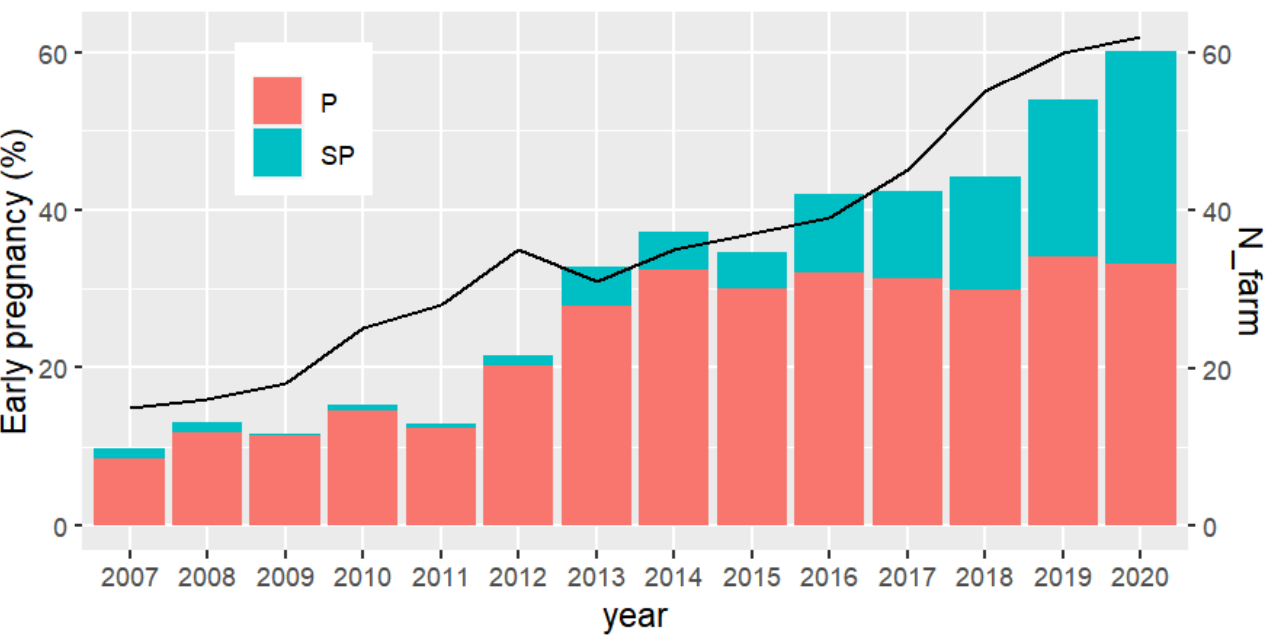
Figure 3. Number of farms (N_farm) implementing the so-called “precocious challenge” (solid line) and percentage of precocious (P) and super-precocious (SP) heifers (bars), according to the year of birth of the first product.